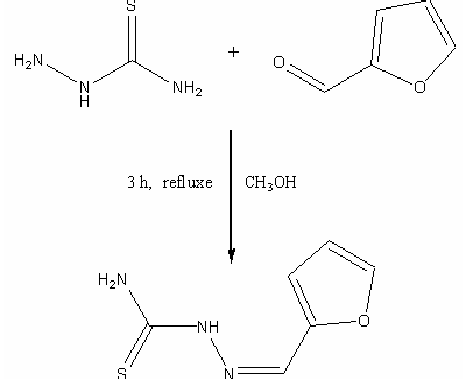
Figure 1. Synthetic and chemical structure of the compound